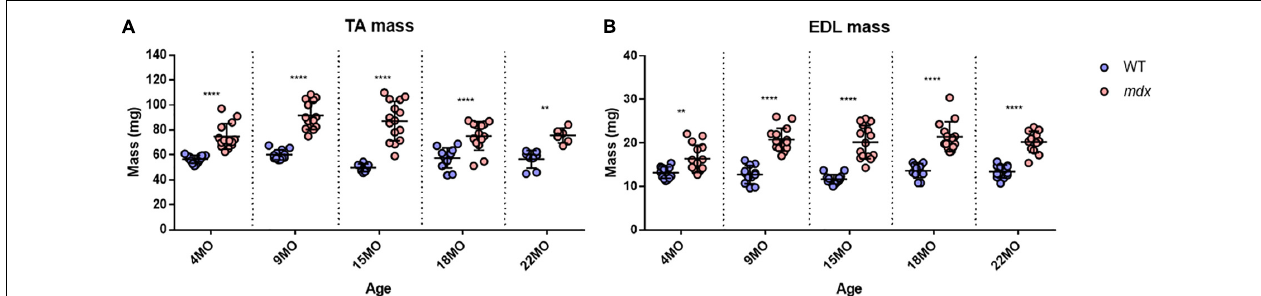
FIGURE 2 | Muscle mass for all age groups. (A) Interleaved scatterplot of tibialis anterior (TA) muscle mass for 4-month ( n = 14 control; n = 14 mdx ), 9-month ( n = 12 control; n = 14 mdx ), 15-month ( n = 8 control; n = 15 mdx ), 18-month ( n = 12 control; n = 14 mdx ), and 22-month ( n = 8 control; n = 6 mdx ) age groups. (B) Interleaved scatterplots of EDL muscle mass for 4-month ( n = 14 control; n = 15 mdx ), 9-month ( n = 12 control; n = 15 mdx ), 15-month ( n = 14 control; n = 15 mdx ), 18-month ( n = 12 control; n = 14 mdx ), and 22-month ( n = 12 control; n = 12 mdx ) age groups. In each group the horizontal line indicates the mean value ± SD. There were no statistical differences between age groups, statistical differences displayed within graphs are differences between genotypes assessed by two-way ANOVA, post hoc analysis using Sidak’s multiple comparisons test. **** P < 0.0001 and **0.001 < P <